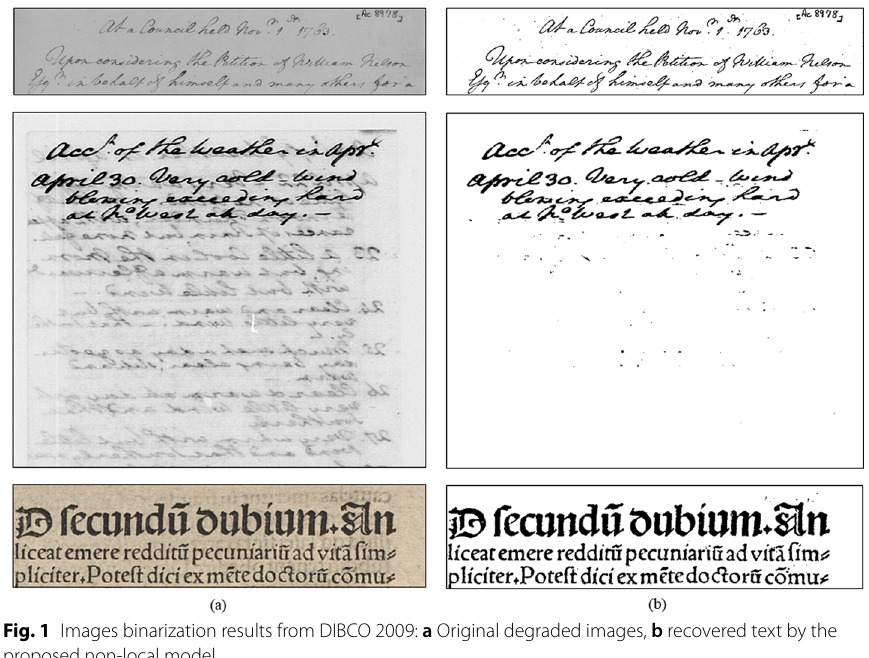
Fig. 1 Images binarization results from DIBCO 2009: a Original degraded images, b recovered text by the proposed non-local model